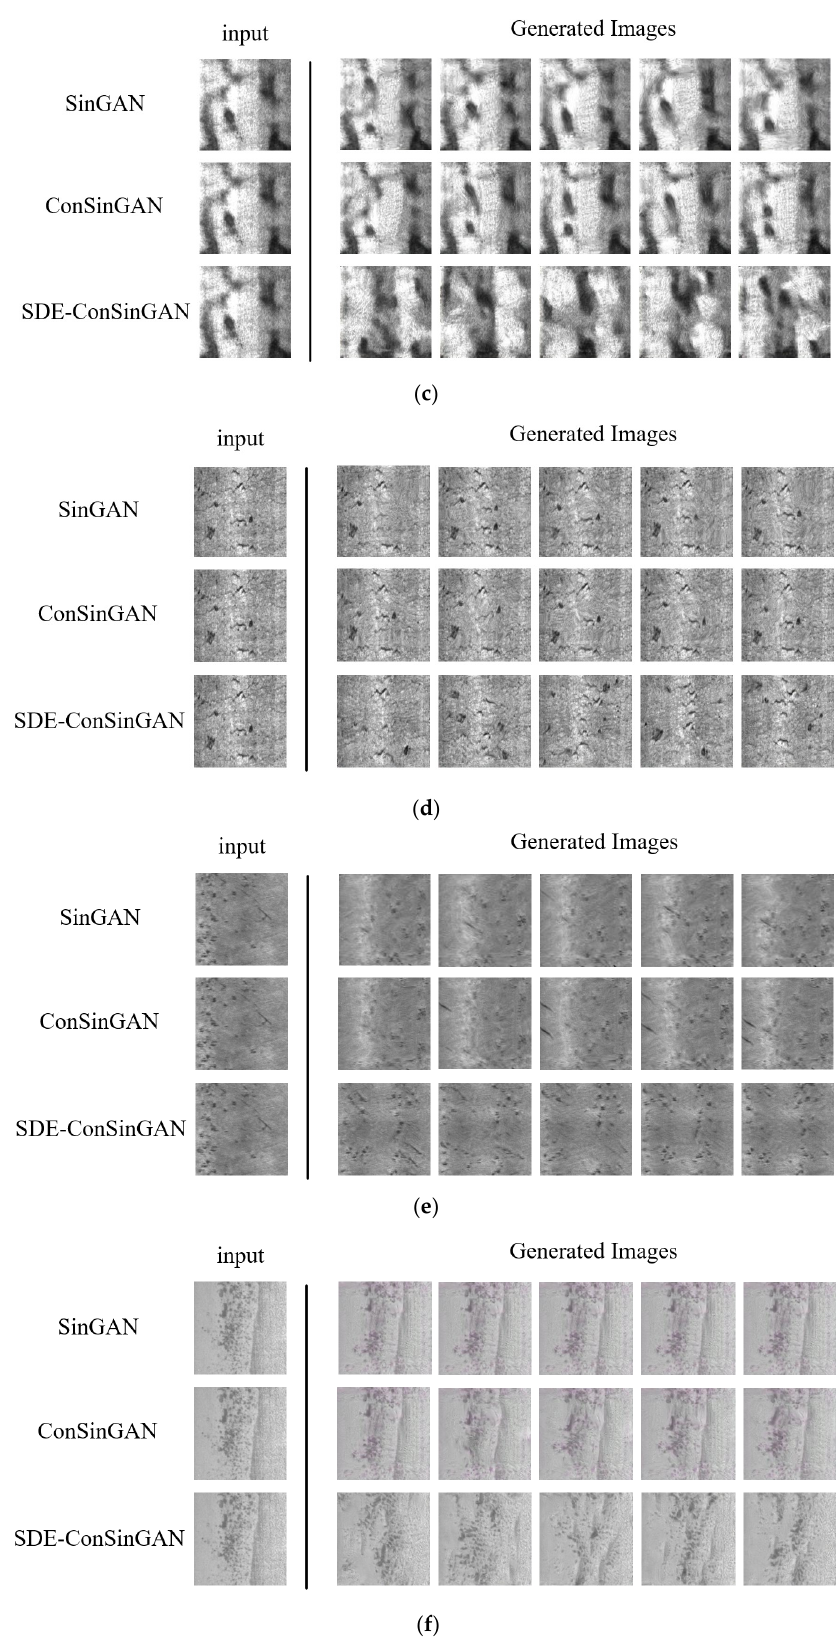
Figure 10. Defect image generation through various image-generation methods. ( a ) Sc. ( b ) In. ( c ) Pa. ( d ) Cr. ( e ) RS. ( f ) PS.